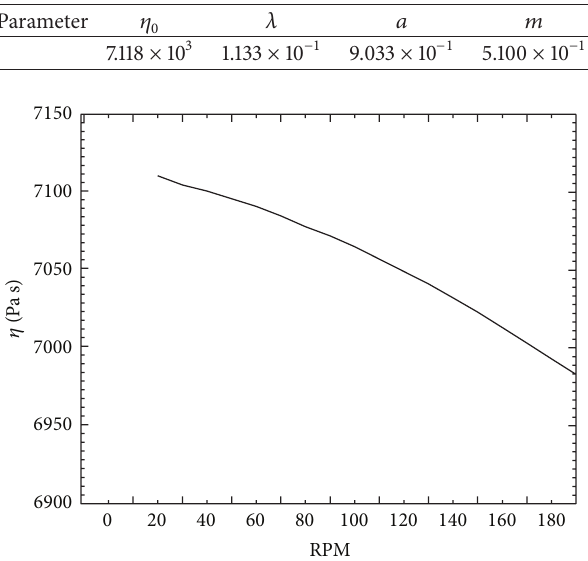
Figure 2: Viscosity as a function of the screw speed (RPM’s).